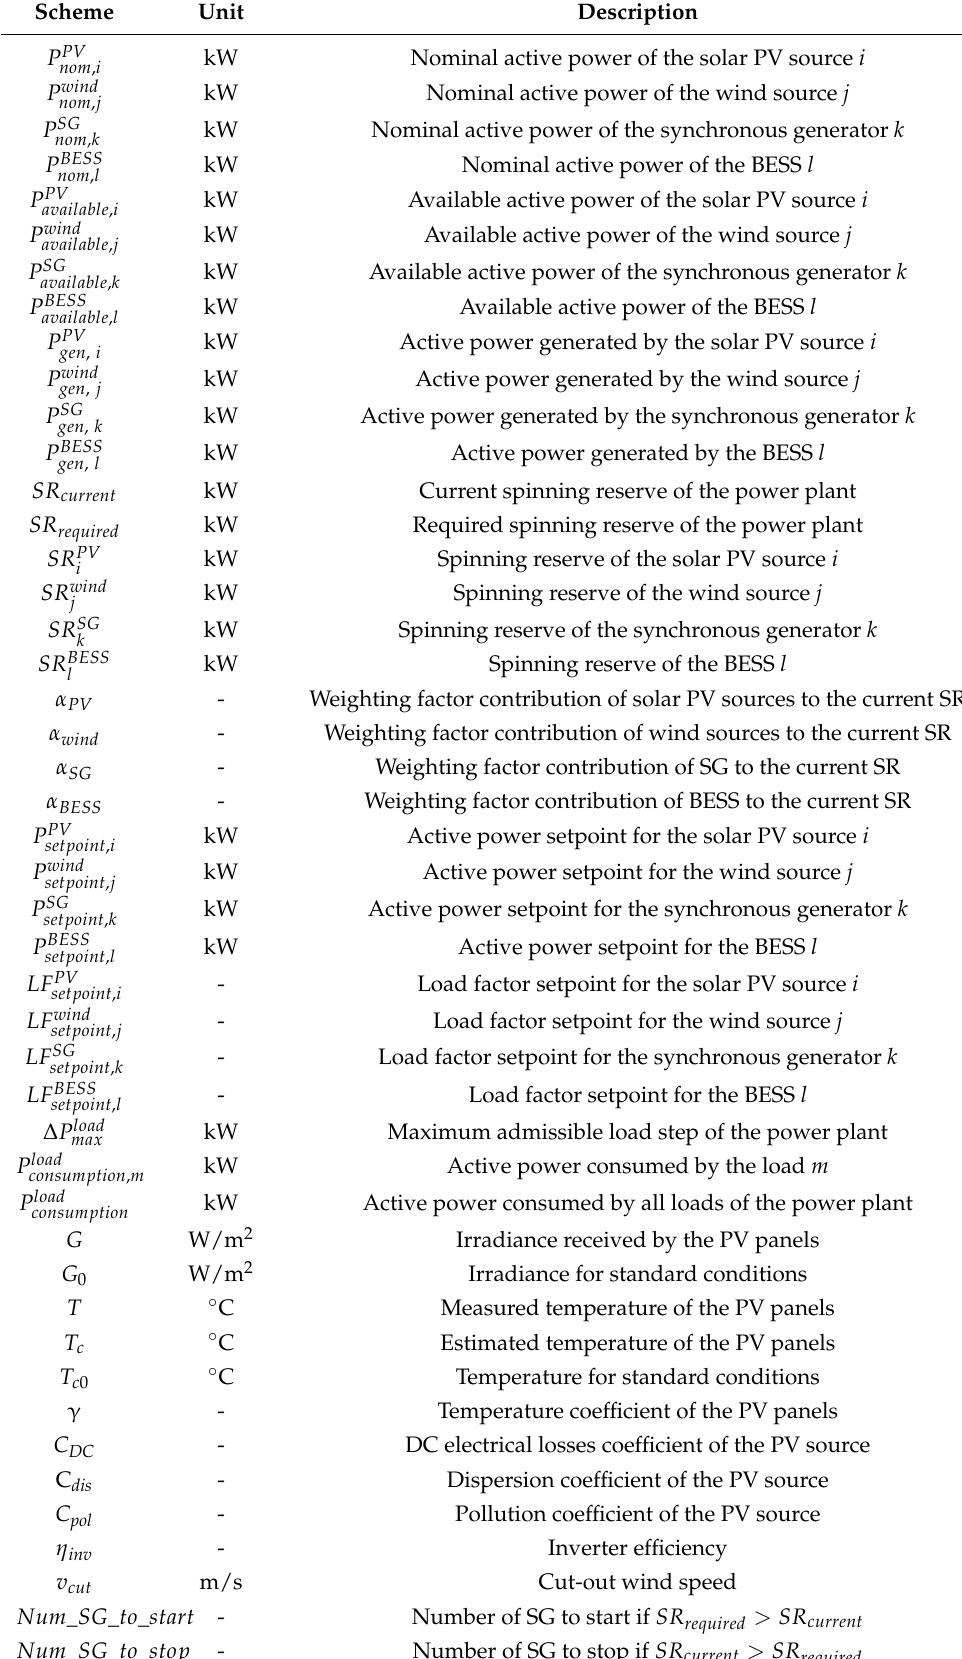
Table A2. Parameters used in the power plant